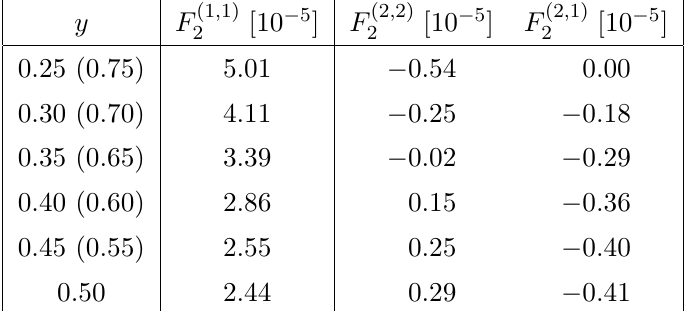
Table 2 . Numerical results for F 2 ( Q 2 , y ) , which captures the Q 2 -dependence of the photon and photon-Z self-energies. F ( L,n f ) denotes corrections with L loops and n closed fermion loops. Re- f 2 sults are shown as a function of y = Q 2 /s , for s = 0 . 011 GeV 2 and SM input parameters in eq.